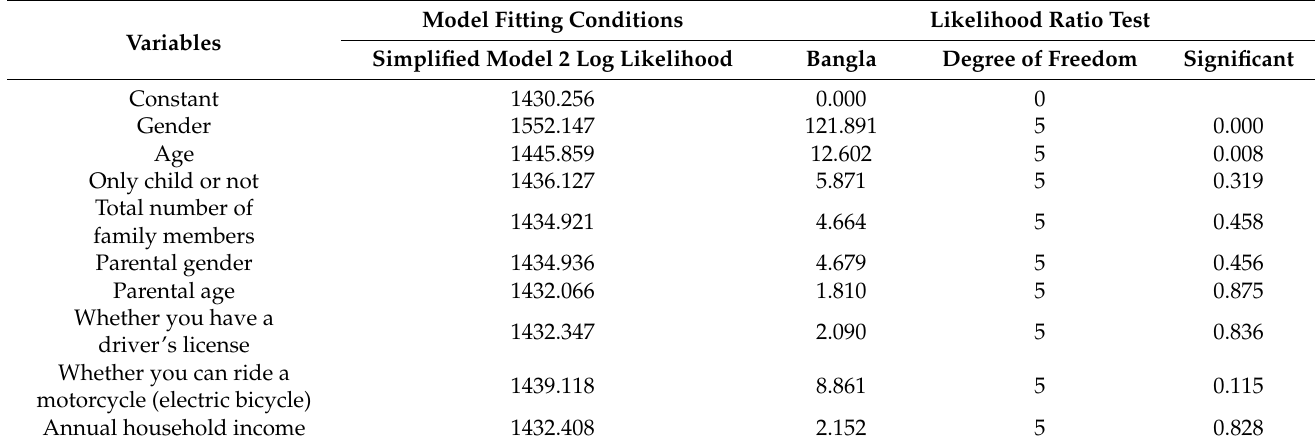
Table 6. Likelihood ratio test for independent